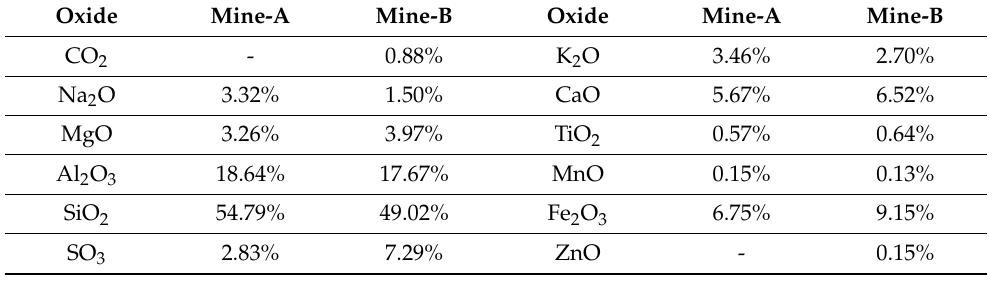
Table 1. Mine-A and Mine-B tailings composition. Table 2. Mine-A and Mine-B tailings characterization.